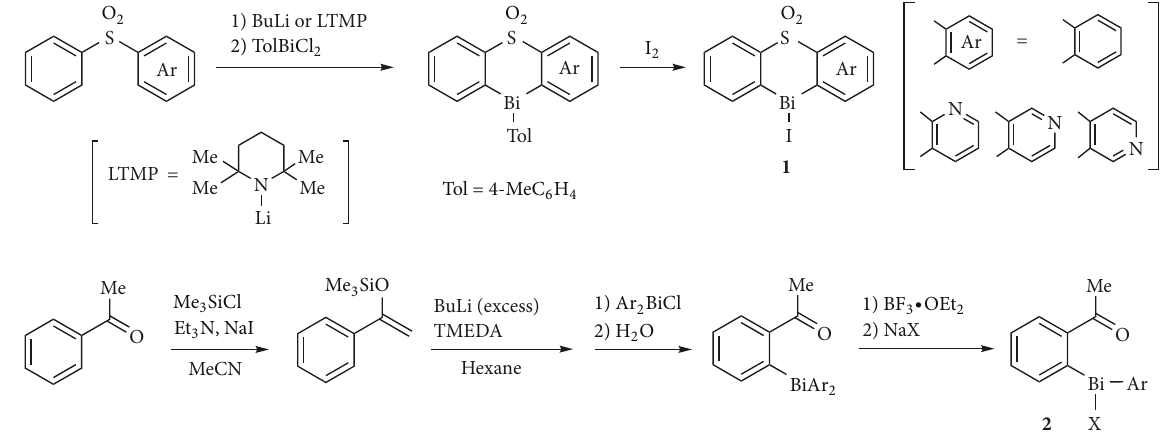
Scheme 1: Synthesis of 1 and 2 by directed lithiation.